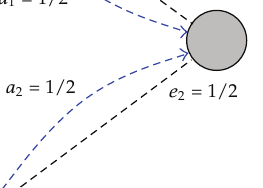
(cid:11) l ≥ 1. (cid:11) l ∈ L (cid:2) v i (cid:3) l (cid:6) 3 / 2. l ∈ L (cid:2) v 1 (cid:3) ∪ L (cid:2) v 2 (cid:3)